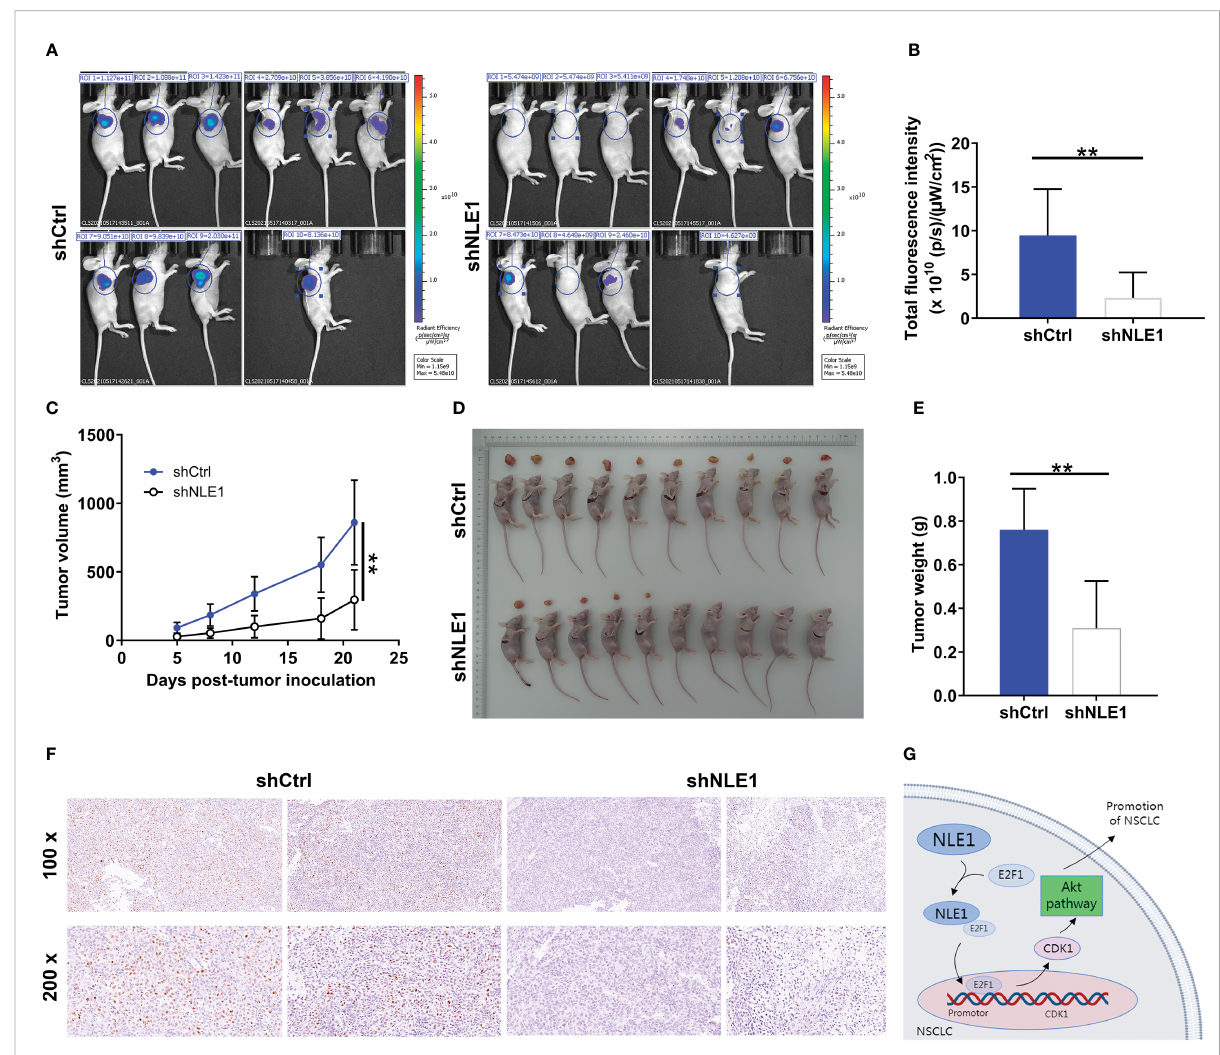
FIGURE 6 NLE1 depletion inhibits xenograft tumors in non − small − cell lung cancer. (A) A nude mice model was constructed through subcutaneously injecting NLE1-de fi cient A549 cells. (B, C) Following cell implantation, the fl uorescence intensity (B) and tumor volume (C) were evaluated at indicated time. (D) The photos of tumors removed from mice models were collected. (E) The weight of xenografted tumors was measured. (F) The pattern of Ki-67 was detected via IHC staining in tumor sections from the mice models. (G) A diagram depicting the mechanism by which NLE1 regulates the development of non − small − cell lung cancer. The data were expressed as mean ± SD (n ≥ 3). ** P <